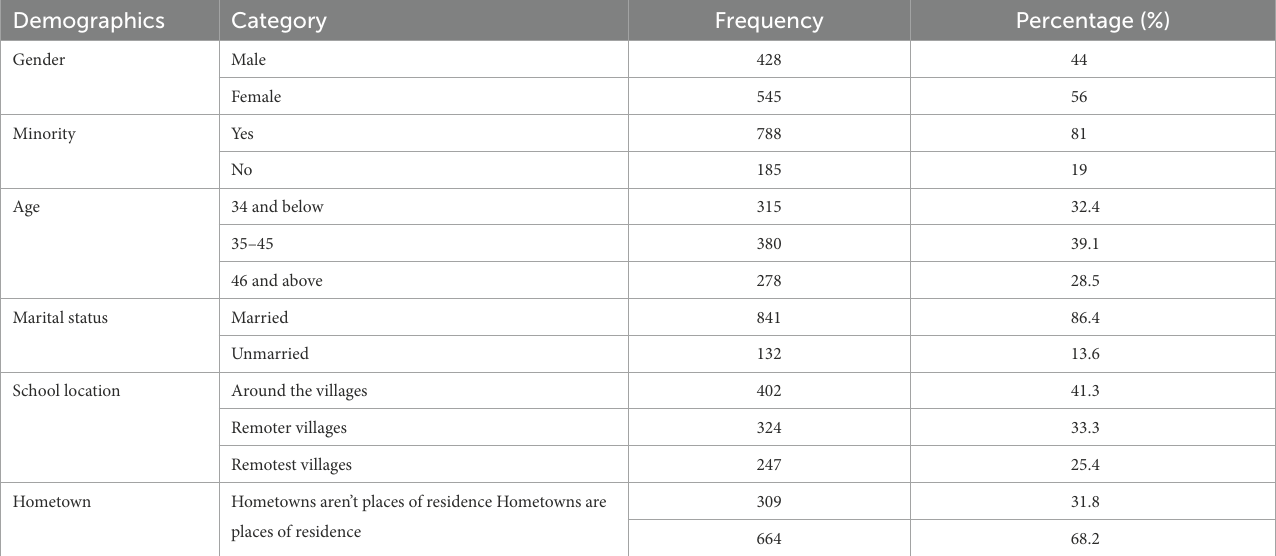
TABLE 1 Demographic profile of participants ( n =